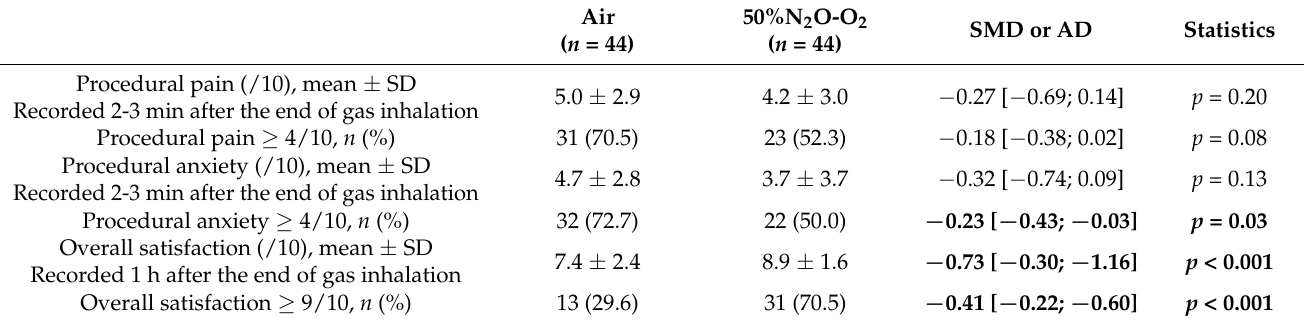
Table 2. Summary of results concerning pain, anxiety, and patient satisfaction (intention-to-treat